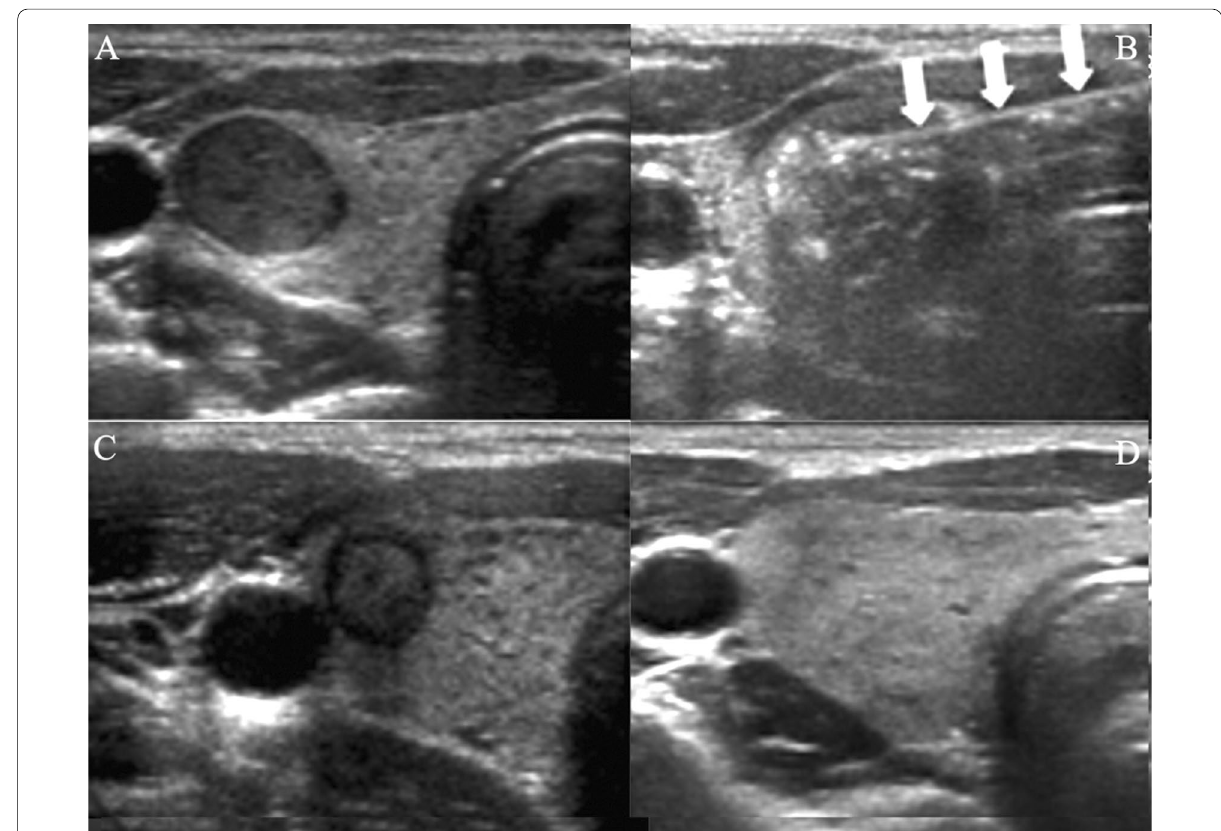
Fig. 4 Percutaneous RFA of 11 mm right lobe PTC. A Axial US scan of right thyroid PTC. B Percutaneous trans isthmic RFA needle (arrows) during RFA treatment. C Volume decreases at 3 month follow-up. D Complete disappearance at 1 year, without further local recurrence to date.